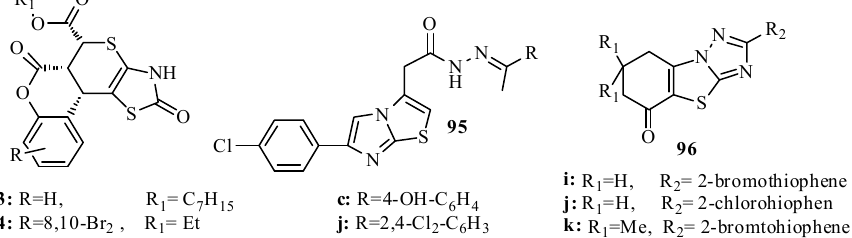
Figure 37. Structures of thiopyrano-[2,3-d][1,3]thiazoles, arylidenehydrazide derivatives bearing imidazo[2,1-b]thiazole moiety and imidazo[2,1- b ]thiazole-based compounds. Güzeldemirci et al. [79] presented the synthesis of arylidenehydrazide derivatives bearing imidazo[2,1-b]thiazole moiety ( 95a – j , Figure 37) and studied their antiviral ac-